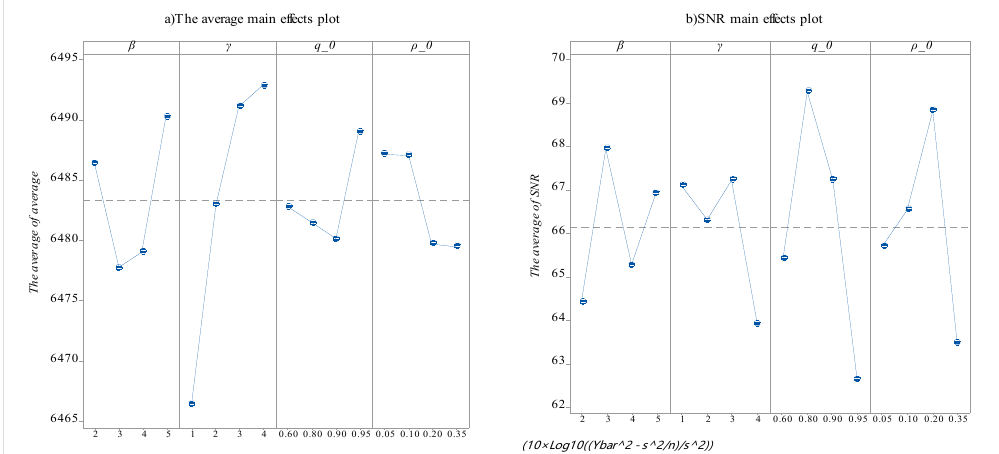
Fig. 6. The average main effects plot and SNR main effects